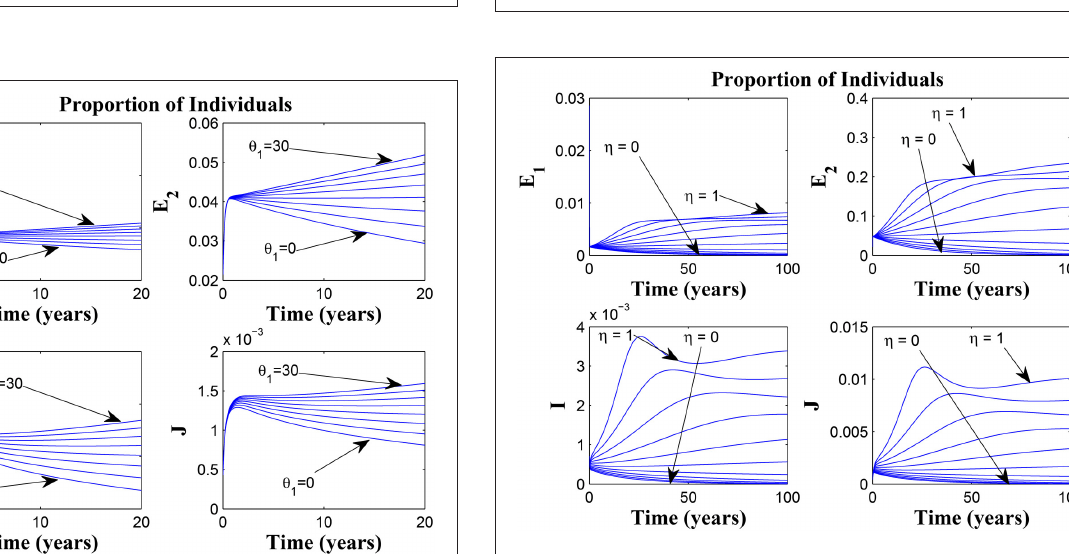
FIGURE 9 | Simulations of model (3) showing the number of infected individuals. Here, the cough identification rate ( α 2 ) is varied from 0 to 30 with θ 1 = 20 and θ 2 = 1 .